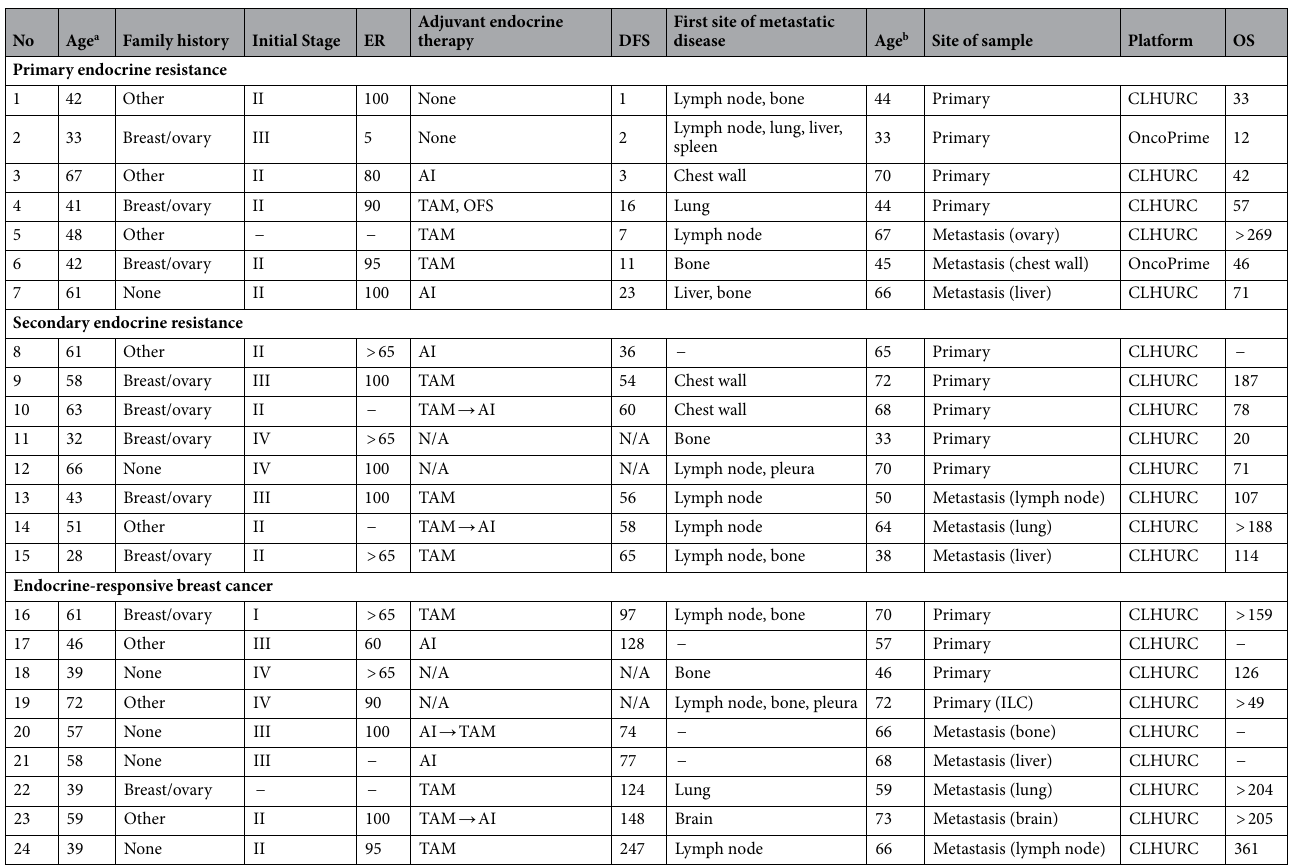
Table 2. Characteristics, treatment, and survivals in 24 patients according to endocrine responsiveness. ER estrogen receptor (% of positive cells), DFS disease-free survival (months), OS overall survival (months), AI aromatase inhibitor, TAM tamoxifen, OFS ovarian function suppression, ILC invasive lobular carcinoma, N/A not applicable, − unknown. a Age at the time of initial diagnosis (years). b Age at the time of clinical sequencing